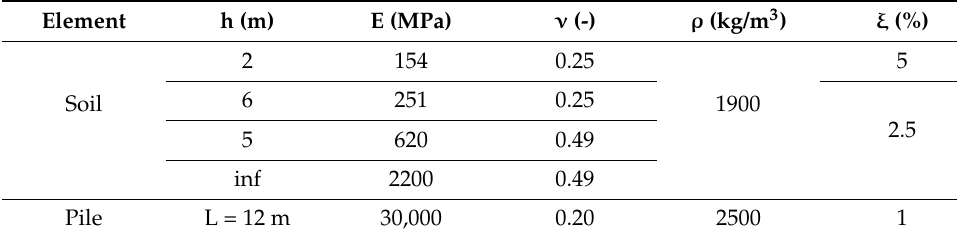
Table 1. Elastodynamic properties of the pile–ground system (E—Young’s modulus; ν —Poisson’s ratio ; ρ —mass density ; ξ —hysteretic damping factor).